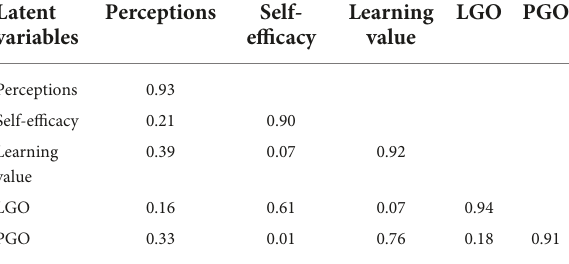
configural invariance was attained. The model fit indices of the metric and scalar invariance model also showed adequate model fit. For the metric invariance, the increase in χ 2